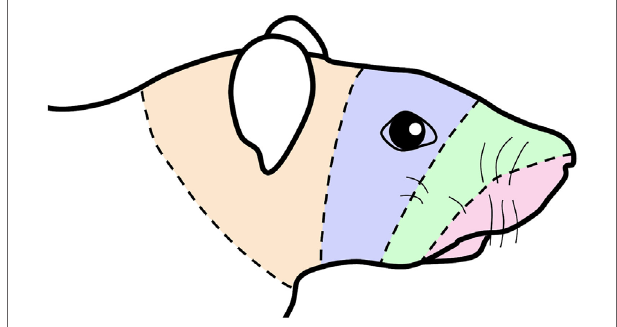
FigUre 5 | Schematic of a rat’s face showing concentric lines arbitrarily drawn similar to those drawn in the human summarizing an “onion skin” hypothesis of facial innervation. The bands of color are transposed from Figure 1 and impose the central representation of nerves in the trigeminocervical complex innervating oral and perioral receptive fields (shaded red) in the rostral medullary dorsal horn (MDH) followed successively by nerves innervating the snout (shaded green), periocular (shaded blue), and periauricular (shaded orange) areas in more caudal areas of the trigeminocervical complex. This illustration thus mimics the existence of hypothetical “cranial dermatomes” and supports their continuity with spinal dermatomes for central orofacial